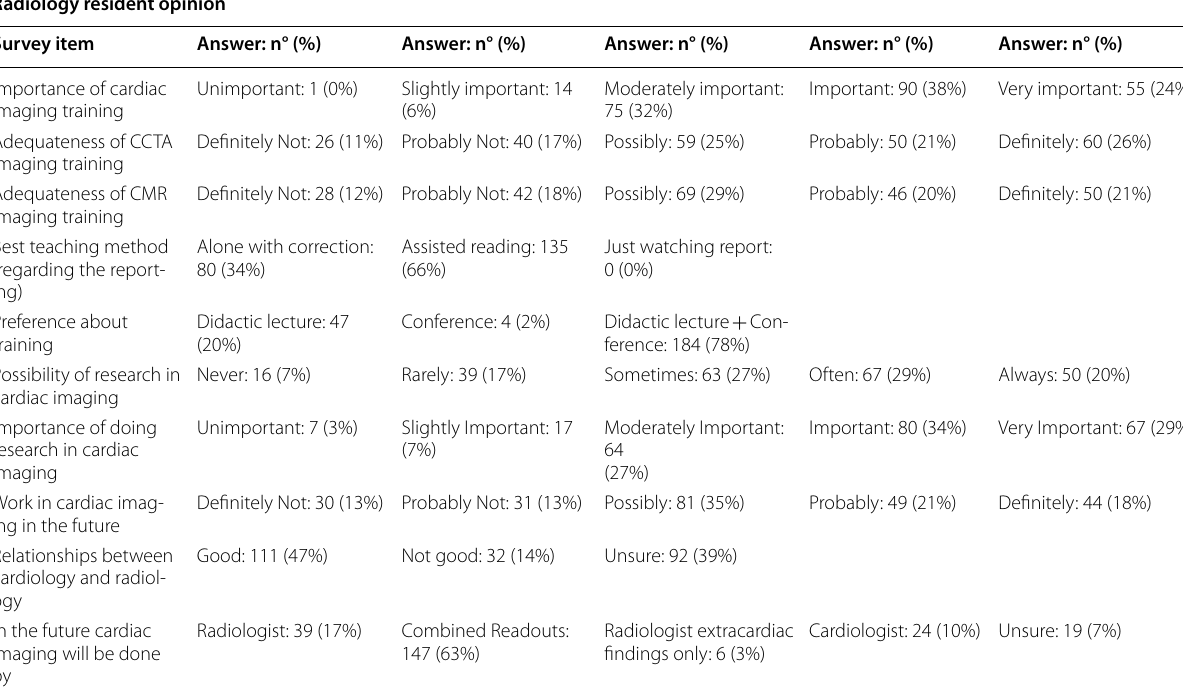
Table 4 Survey Sect. 2: questions and answers about the radiology resident’s opinion Radiology resident